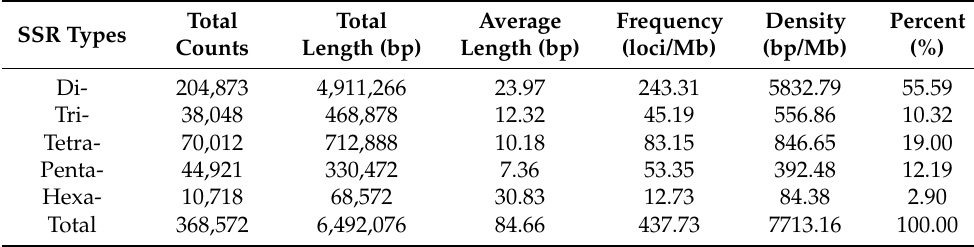
Table 3. Information of SSR repeats in H. molitrix